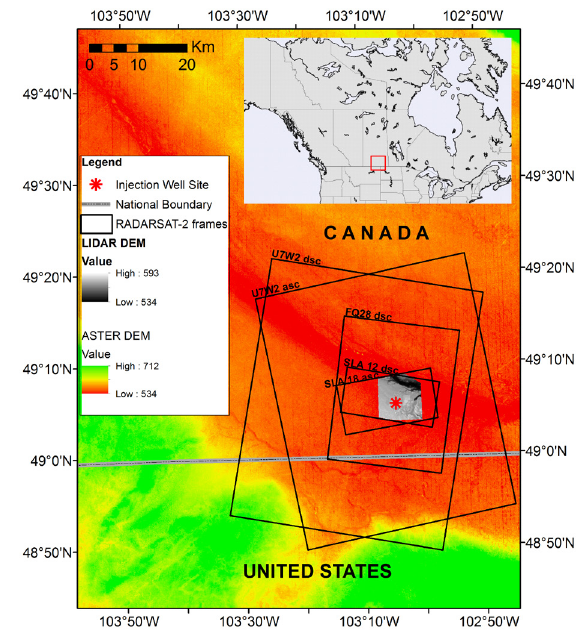
Figure 2. Location of the Aquistore project study area (denoted by orange asterix), southeastern Saskatchewan. Ascending and descending RADARSAT-2 frames used in the study are outlined in black. Background is 30m ASTER Digital Elevation Model. Test injection site is covered by 1m LiDAR Digital Elevation Model.